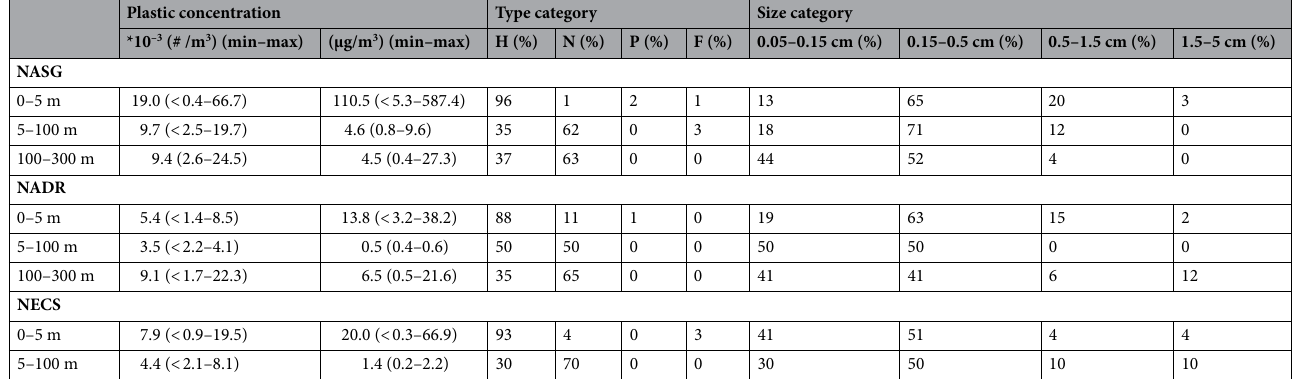
Table 1. Average numerical and mass concentrations of plastic debris (0.05–5 cm in size) observed in distinct water layers of three different biogeochemical provinces in the North Atlantic Ocean and corresponding plastic type and size distributions (in % of total plastic particle counts). Values in parentheses refer to the minimum and maximum measured concentration in the respective water layer and province. NASG = North Atlantic Subtropical Gyre, NADR = North Atlantic Drift Region, NECS = Northeast Atlantic Continental Shelves. Plastic categories correspond to fragments and objects made of hard plastic (H), fragments of plastic lines, ropes, and fishing nets (N), pre-production plastic pellets (P), and fragments or objects made of foamed material